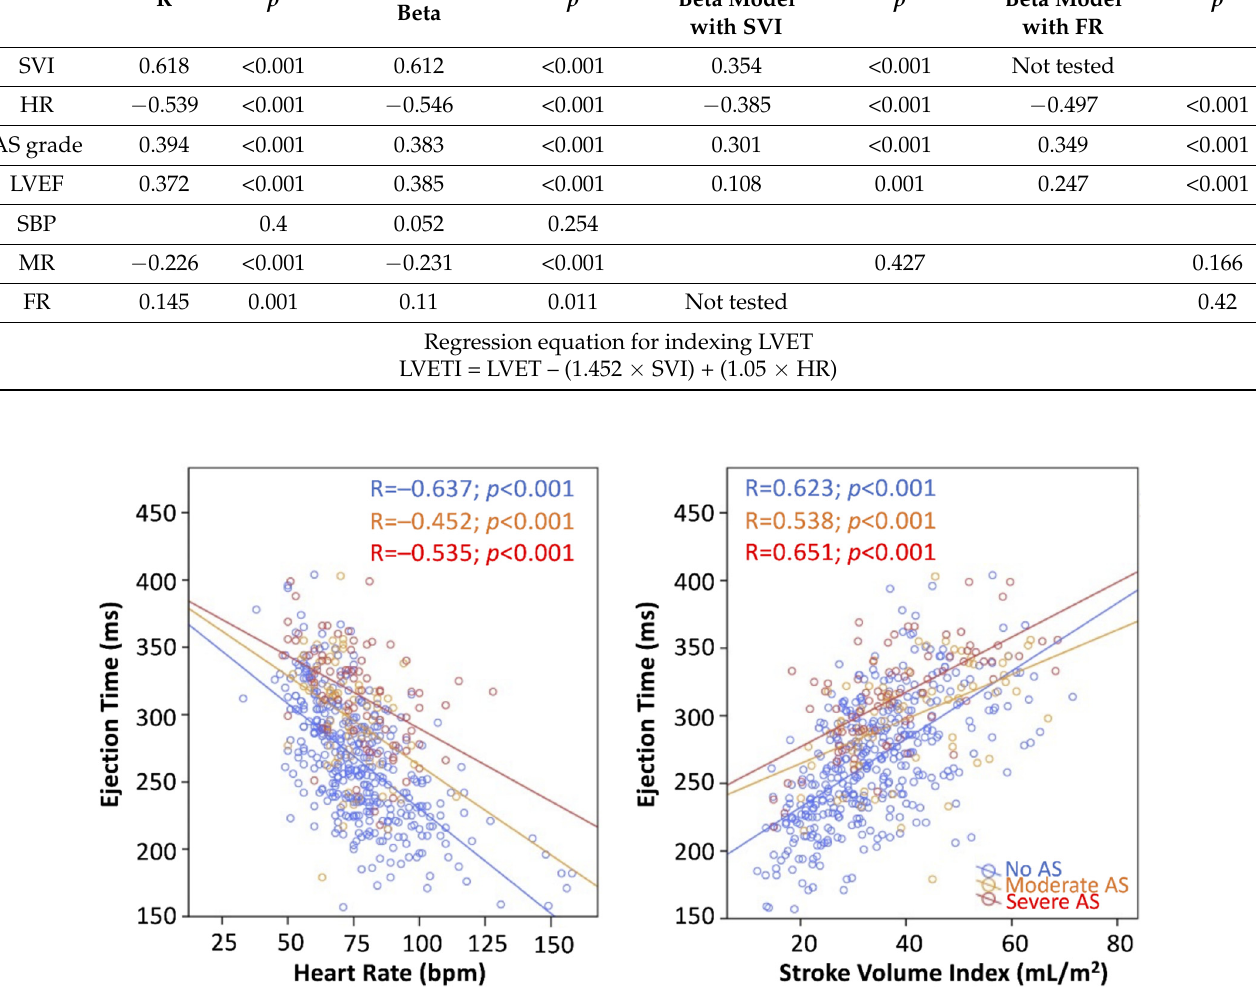
Figure 4. Scatterplot of left ventricular ejection time versus heart rate ( left ) and stroke volume index ( right ), according to aortic stenosis (AS) grading. Table 3. Incremental models with stepwise linear regression